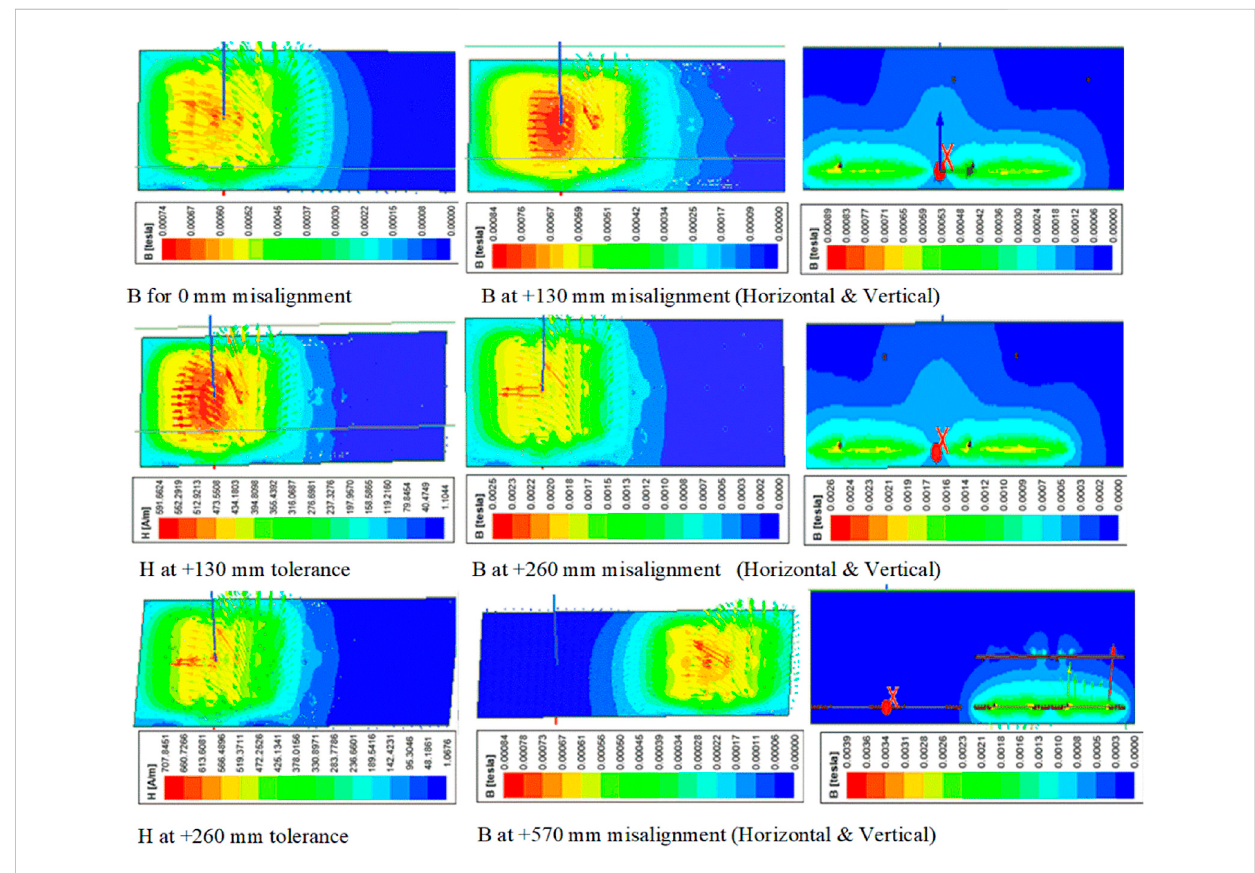
FIGURE 11 Magnetic fi eld variations for various misalignment